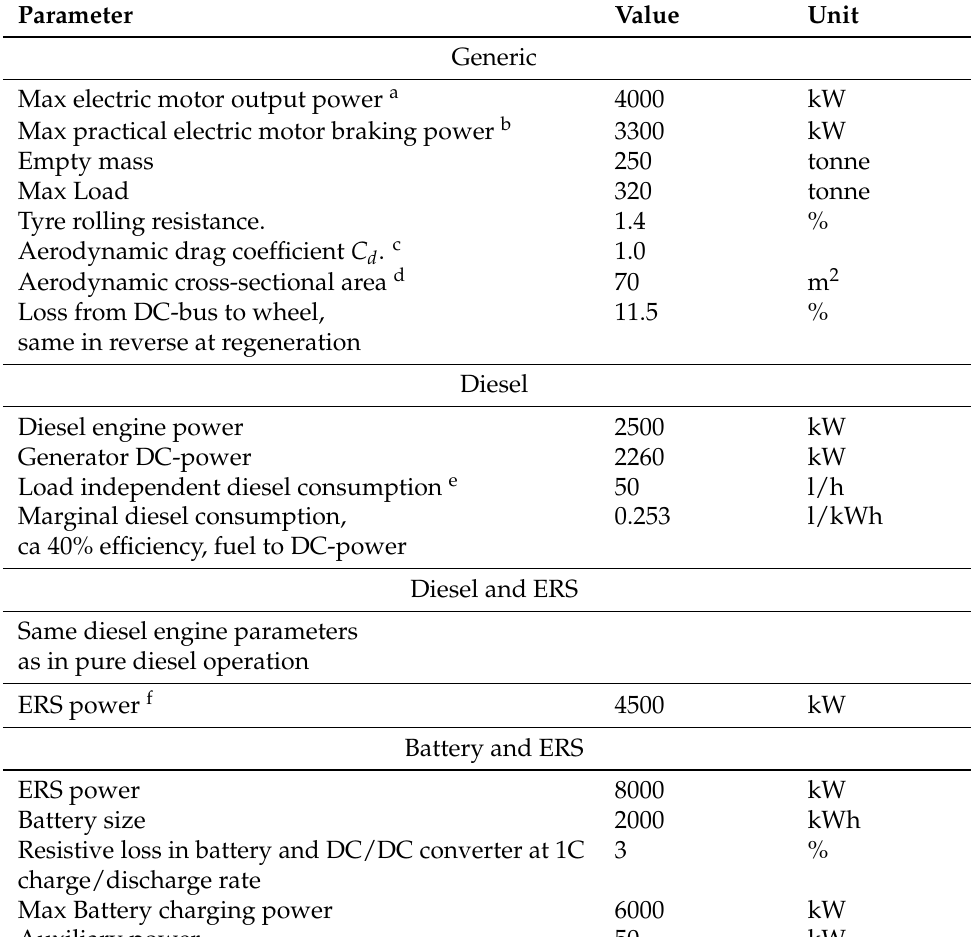
Table 2. The main vehicle